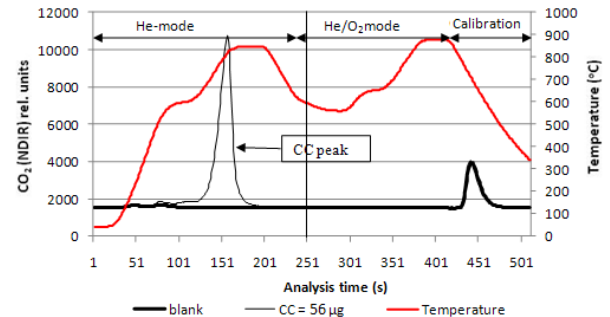
Fig. 6. RT -QUARTZ-840 thermogram for a blank and a CC-loaded filter (56µg) (He-mode: 1–673s, He/O 2 -mode: 674–1063s and Calibration-mode: 1064–1163s). The vertical line represents the splint point between OC and EC. The response of the NDIR detec- tor is given in relative